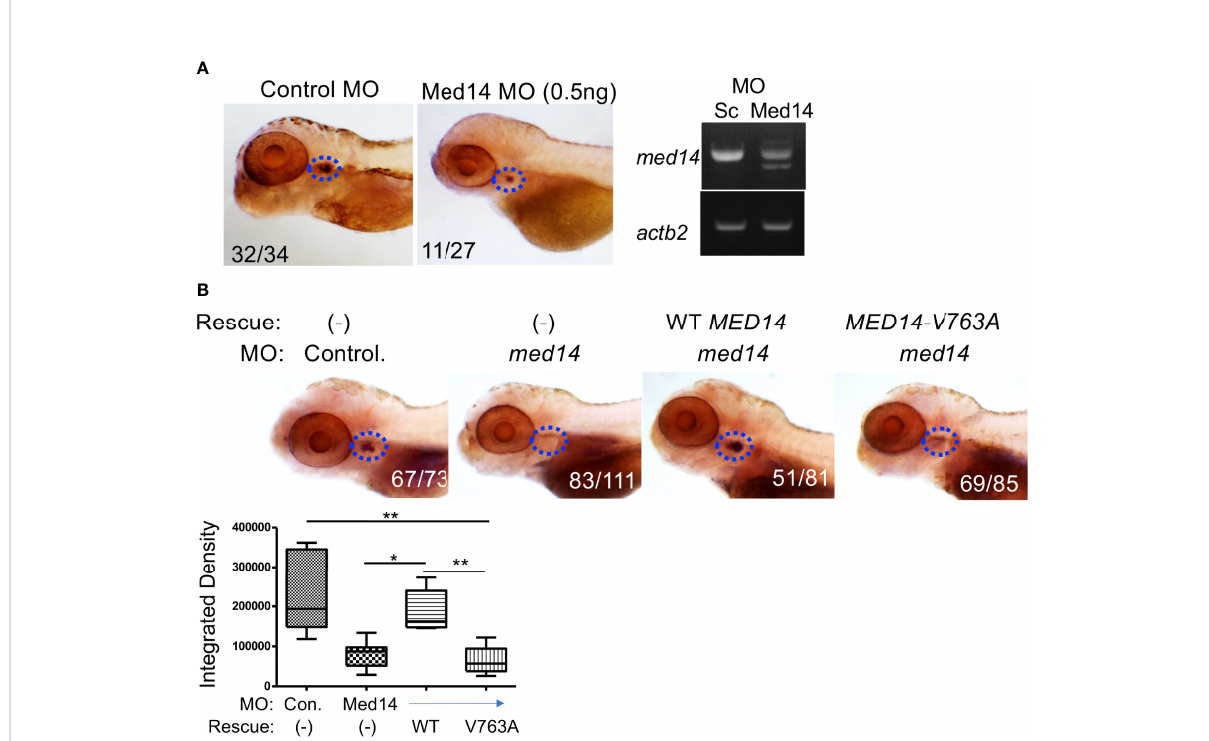
FIGURE 2 Role of Med14 in Zebra fi sh T cell Development. (A) The effect of MO knockdown of med14 on T cell development at 5 dpf was assessed by WISH using an lck probe to identify T cells. The numbers on the images re fl ect the fraction of the embryos with the depicted staining pattern. Thymus staining is outlined by blue dashed ovals. The panel on the right con fi rms MO induced mis-splicing of med14 mRNA by RT-PCR at 1 dpf with b -actin ( actb2) as a loading control. (B) The ability of the wild type and human MED14 variant to rescue loss of endogenous zebra fi sh med14 was assessed by heat-inducible re-expression of wild type or variant MED14. The effect on T cell development was assessed as above by WISH using an lck probe. The integrated density of WISH staining was measured by ImageJ software and depicted graphically as box plots. Signi fi cantly altered groups are indicated. Data are representative of 3 experiments. * p < 0.05, ** p <